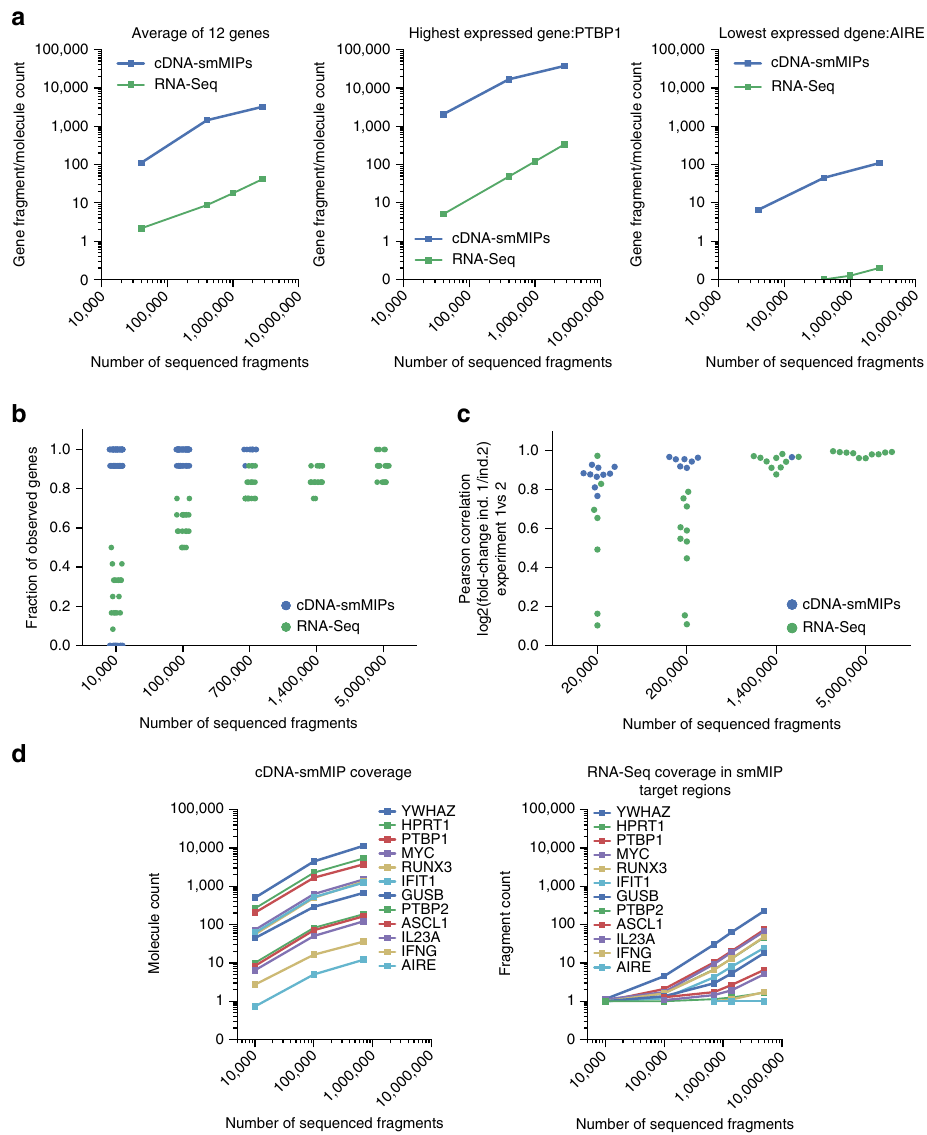
Figure 3 | Comparison of cDNA-smMIPs with low-coverage RNA-Seq. ( a ) Differences in molecule count (cDNA-smMIPs) and fragment count/read pairs (RNA-Seq) for the 12 genes targeted in the cDNA-smMIPs assay. The data points are averages over the randomly sampled sets of fragments. ( b ) Fraction of detected genes (genes with at least one mapped read) as a function of total number of reads. Each data point corresponds to a replicate. ( c ) Reproducibility of fold changes was estimated as a function of the total number of sequencing read pairs. For cDNA-smMIPs, the correlation is between log2(fold change) estimated in experiment 1 (using two technical replicates per individual) and experiment 2 (two technical replicates per individual). For the low-coverage RNA-Seq, correlation is between log2(fold change) estimated in experiment 1 (one technical replicate for respectively individual HG00117 and NA06986) and experiment 2 (one technical replicate for each individual). Each data point corresponds to a random sampling (without replacement) of the number of fragments ( ¼ read pairs) given on the horizontal axis and is based on 8 and 4 technical replicates for respectively cDNA-smMIPs and RNA-Seq. Corresponding scatter plots between the replicate DE estimates are shown in Supplementary Fig. 10. ( d ) Comparison of molecule counts (cDNA-smMIPs) and fragments/read pairs (RNA-Seq) mapping to the regions targeted by the cDNA-smMIPs. For each gene the average count across all smMIPs targeting the same gene is